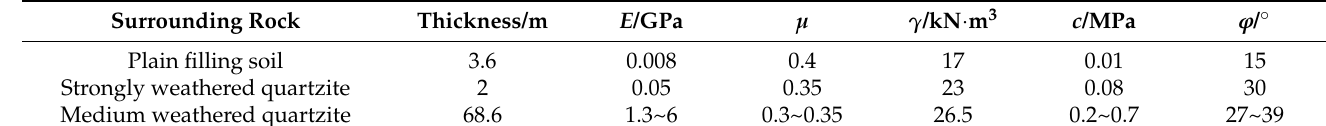
Table 3. Basic mechanical parameters of surrounding rock.